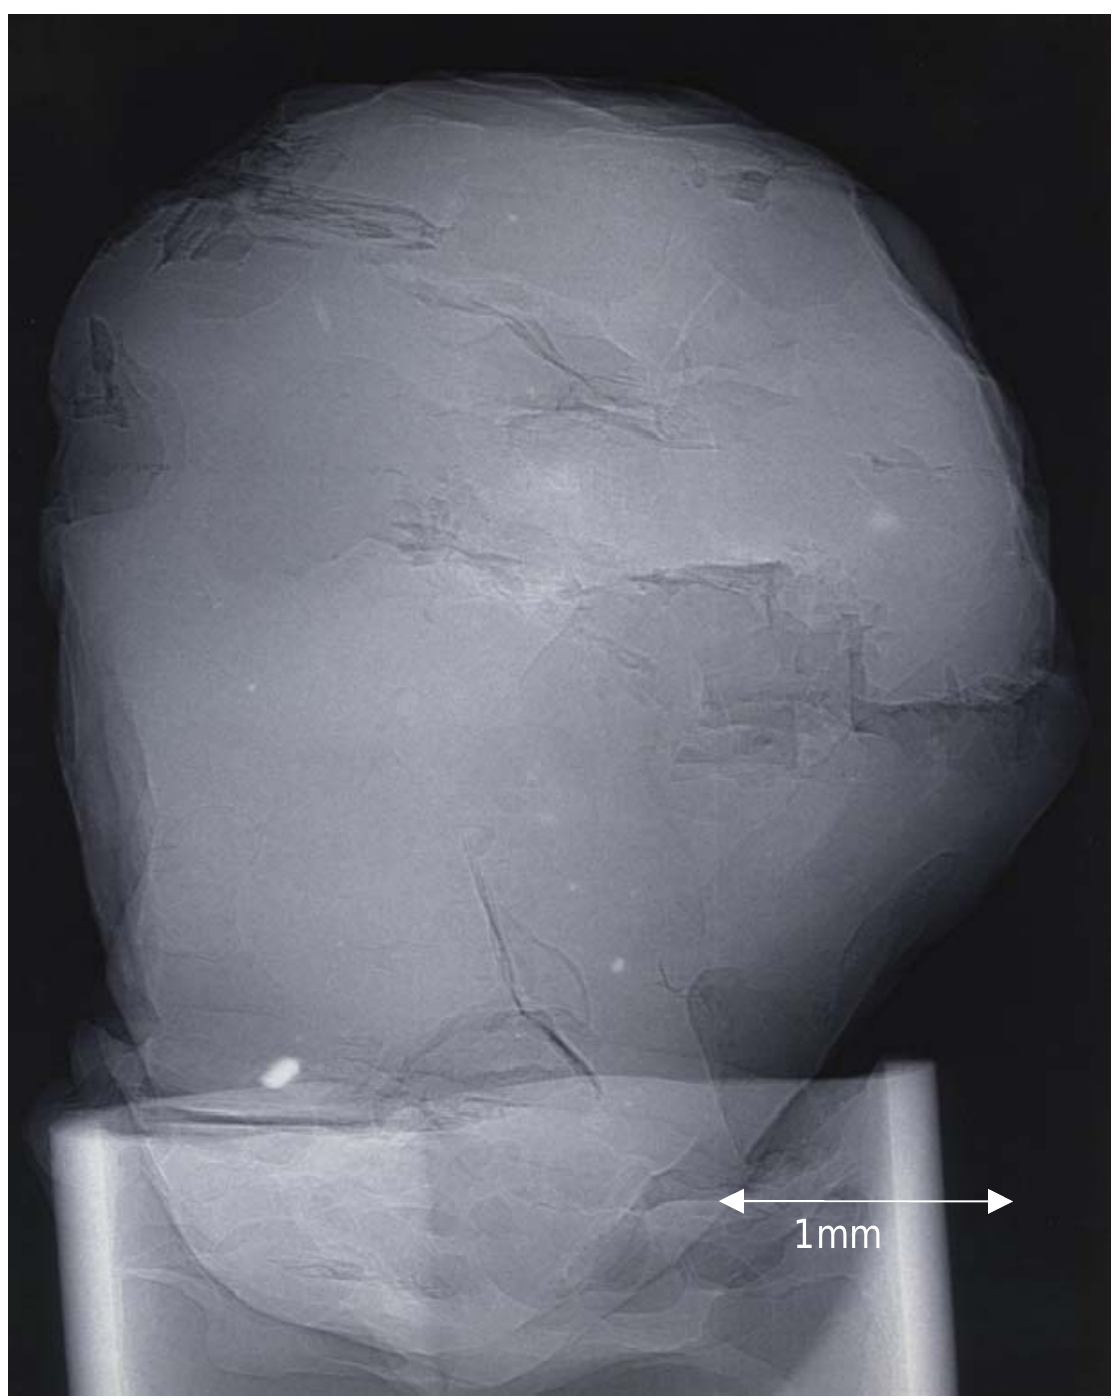
Figure 3. PCX image of a small industrial diamond: 30 kVp, 50 μ A; source-to-sample distance = 10 cm; sample-to-detector distance = 190 cm; exposure time 120